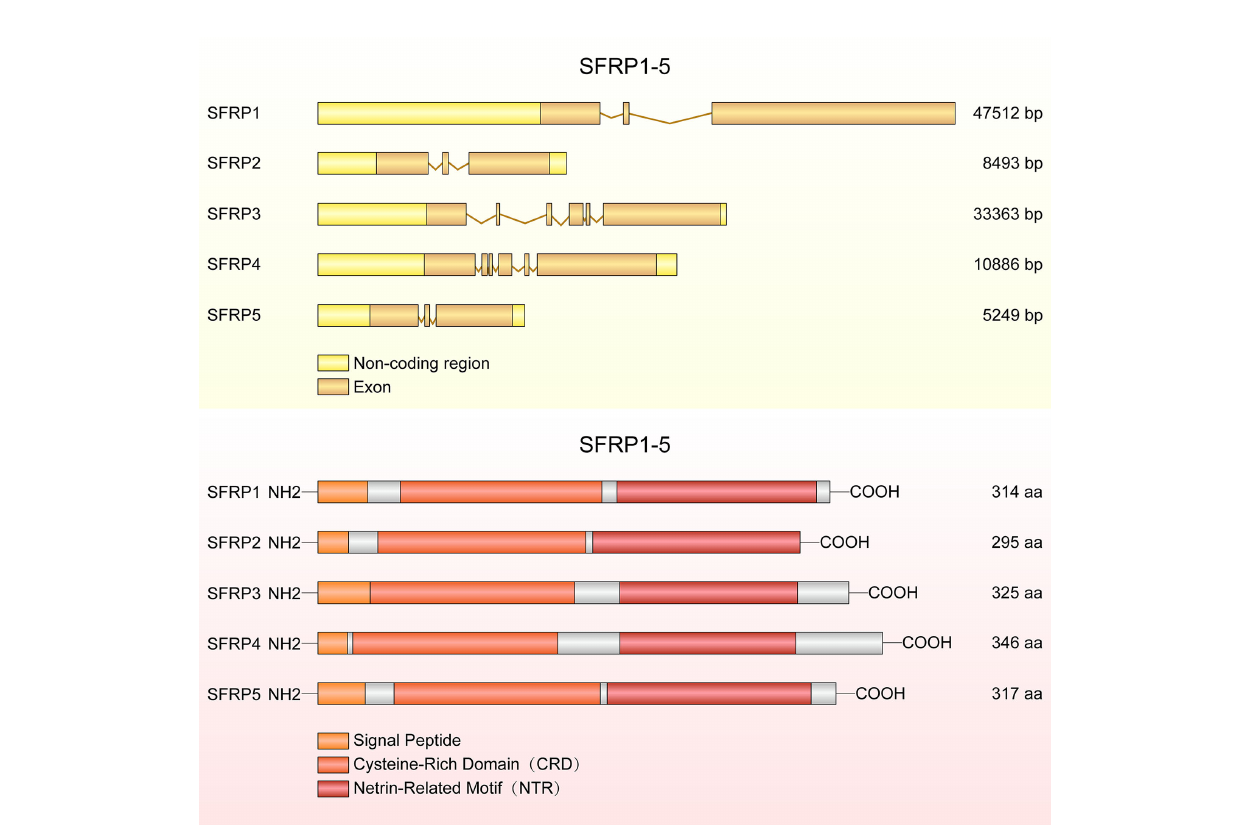
FIGURE 1 | The structure of SFRP genes andproteins. The diagram shows SFRP1 , SFRP2 and SFRP5 each containing three exons, but SFRP3 and SFRP4 containing six exons. SFRPs have common structural features with a signal peptide comprising 20-30 aminoacids, a cysteine rich domain (CRD) and a netrin